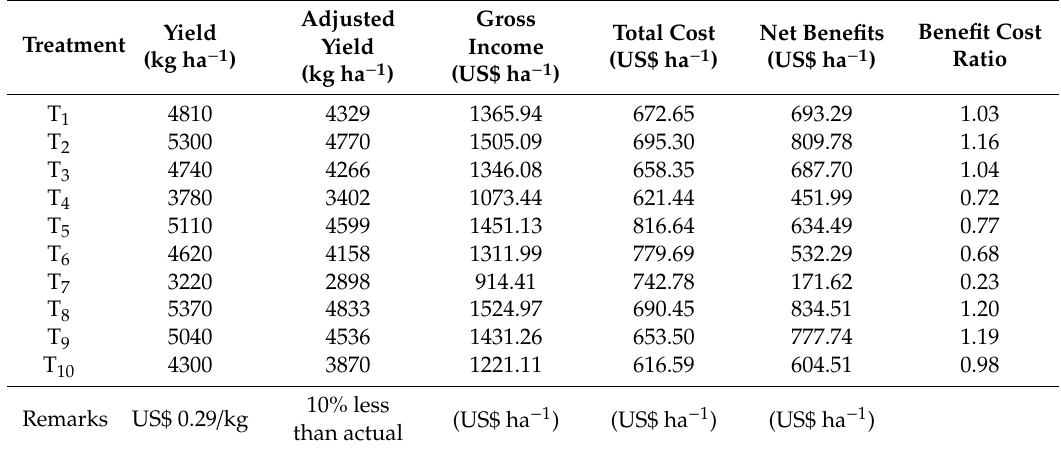
Table 6. Economic analysis of wheat grown in various chemical fertilizer and vermicompost treatments.